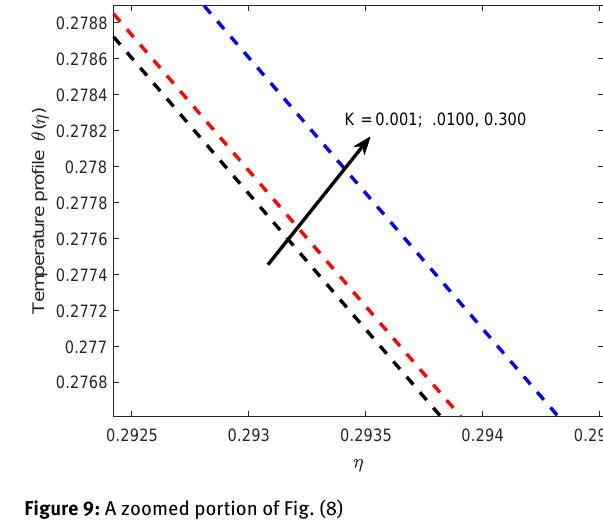
Figure 7: A zoomed portion of the free stream of Fig.(5)